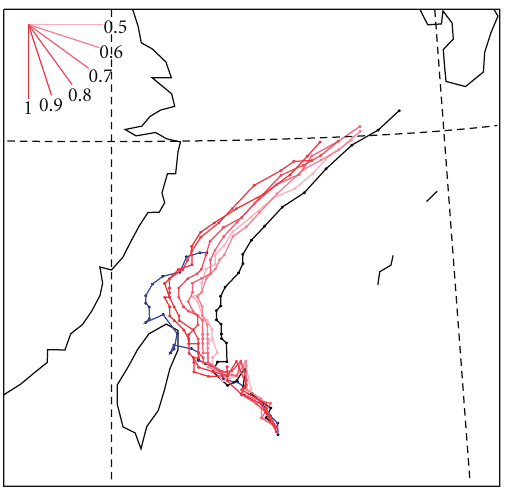
Figure 5: The tracks from forecasts initialized at 1800 UTC, 12 September 2008, with VAR SCALING = 0.1 and LEN SCALING = 0.5–1.0 step 0.1. Color scale is shown at the upper left corner, black curve is the control run without AIRS data, and blue curve is the observed